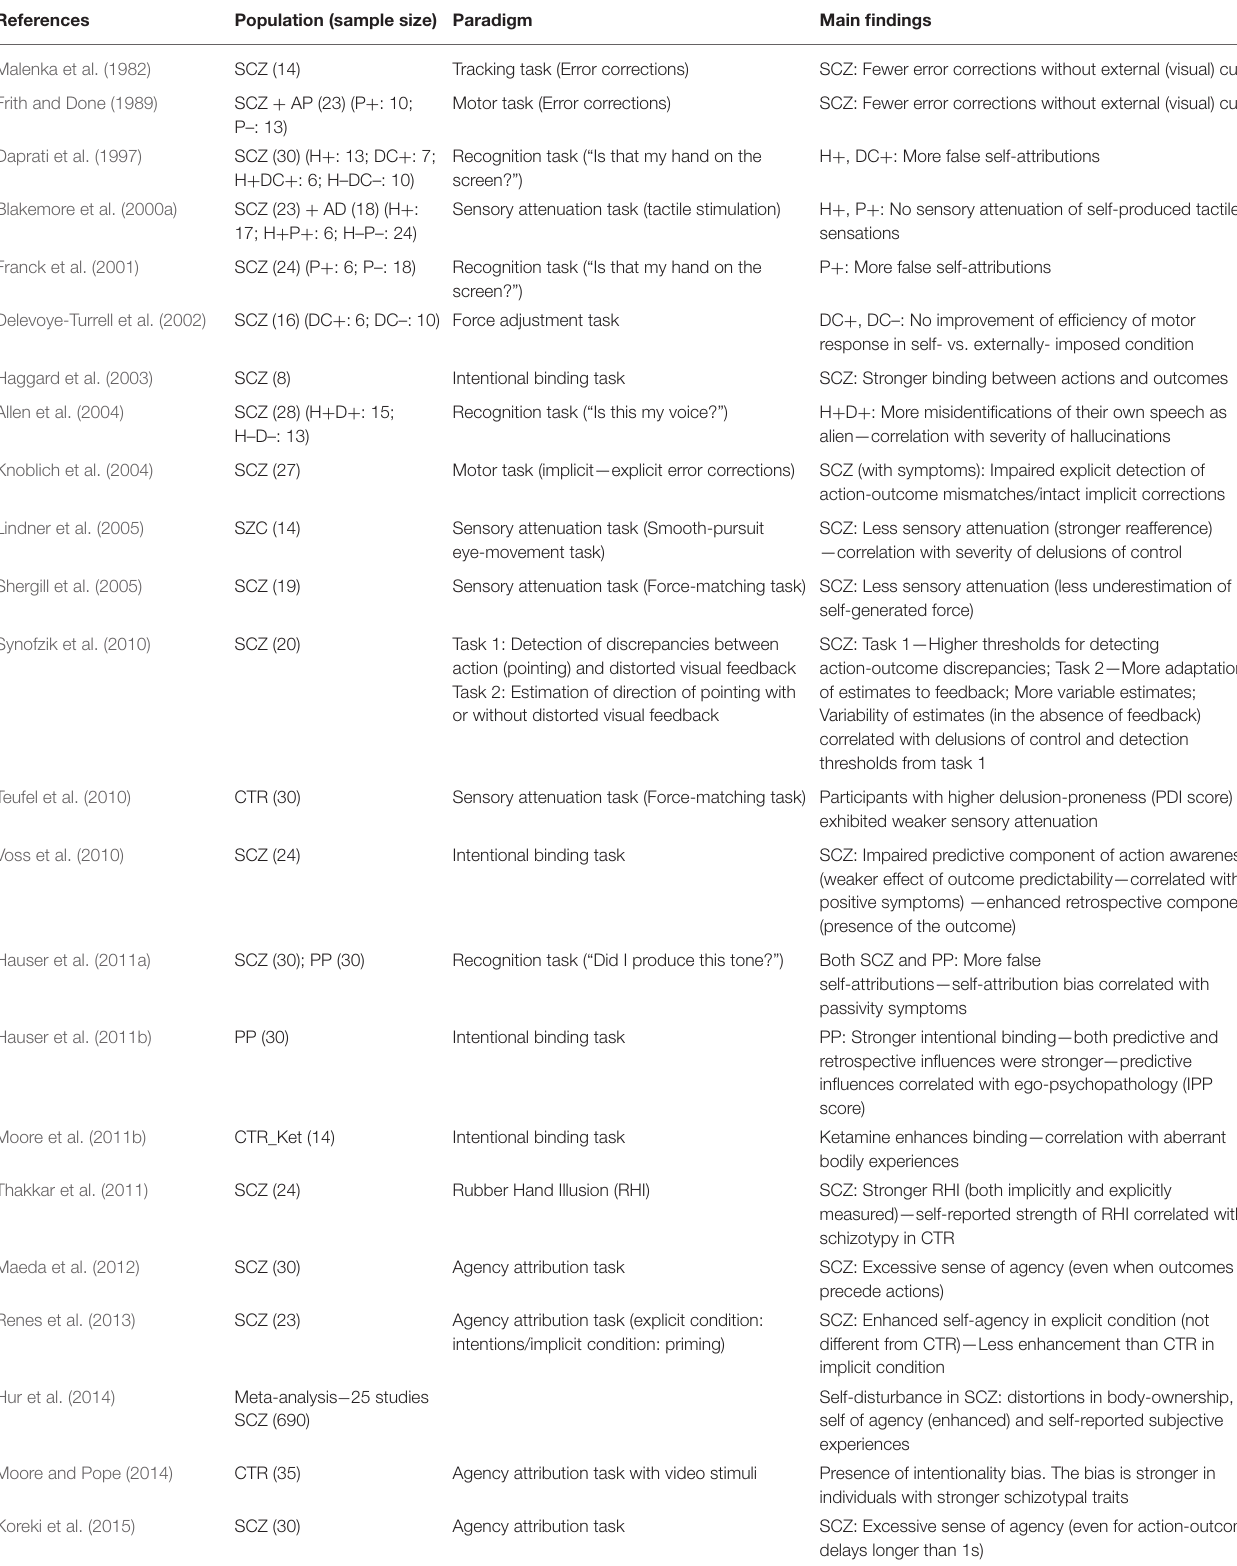
TABLE 1 | Sense of agency/ownership (implicit and explicit measures) in psychosis: main empirical